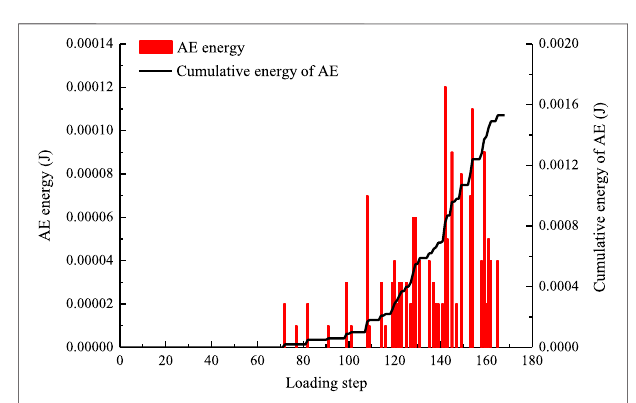
FIGURE 14 | AE energy curve of anchored rock with the positive Poisson ’ s ratio bolt.